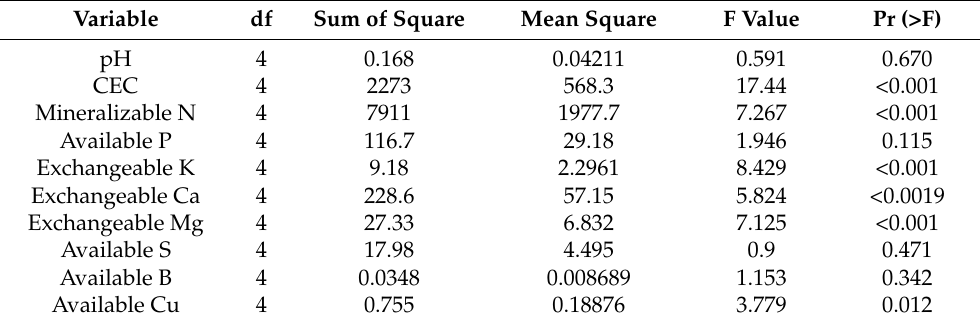
Table 2. Summary of analyses of variance results for testing effects of soil parent material on soil chemical characteristics.